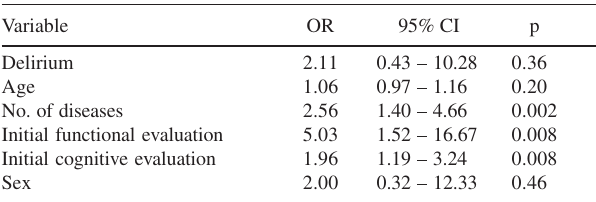
Table 4 - Univariate analysis of present functional evaluation Variable OR 95% CI Delirium